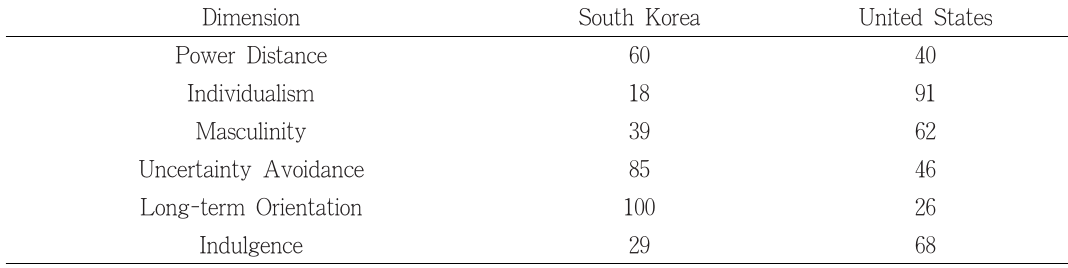
<Table 1> South Korea vs. the United States on Hofstede’s Six Cultural